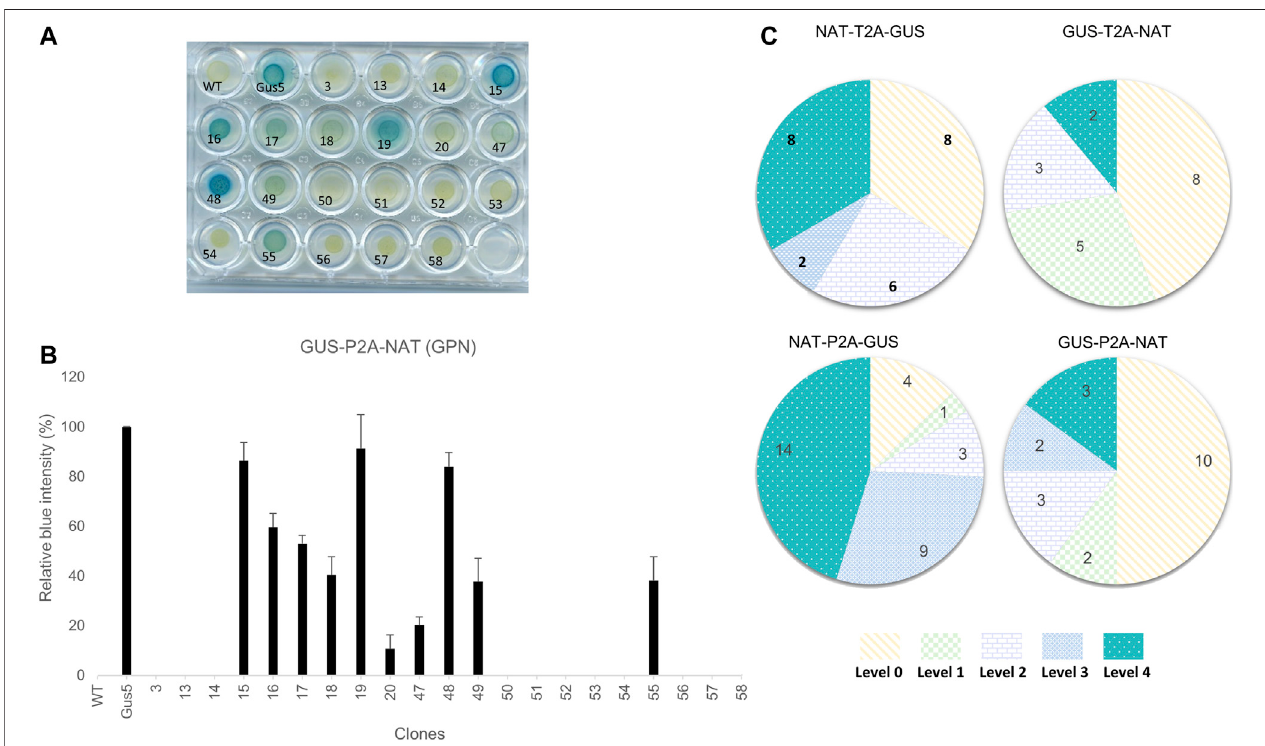
FIGURE2| Phenotypiccharacterizationoftransformantsandclassi fi cationbasedoncolorintensity. (A) Exampleofthe β -glucuronidaseactivityassayonthe20clonesfrom theGUS-P2A-NATconstruct.Gus5,asthereferencestrain,wasgivenavalueof100%andwildtype,aswellasstrainsfromtransformationwithNATvector(clone3),weregivena value of 0%. (B) Bar chart of therelative color intensity calculated for the GUS-P2A-NAT clones. The presented values are averages ofthe relativecolor intensity at 24 h for three independentcolorimetricexperiments. (C)